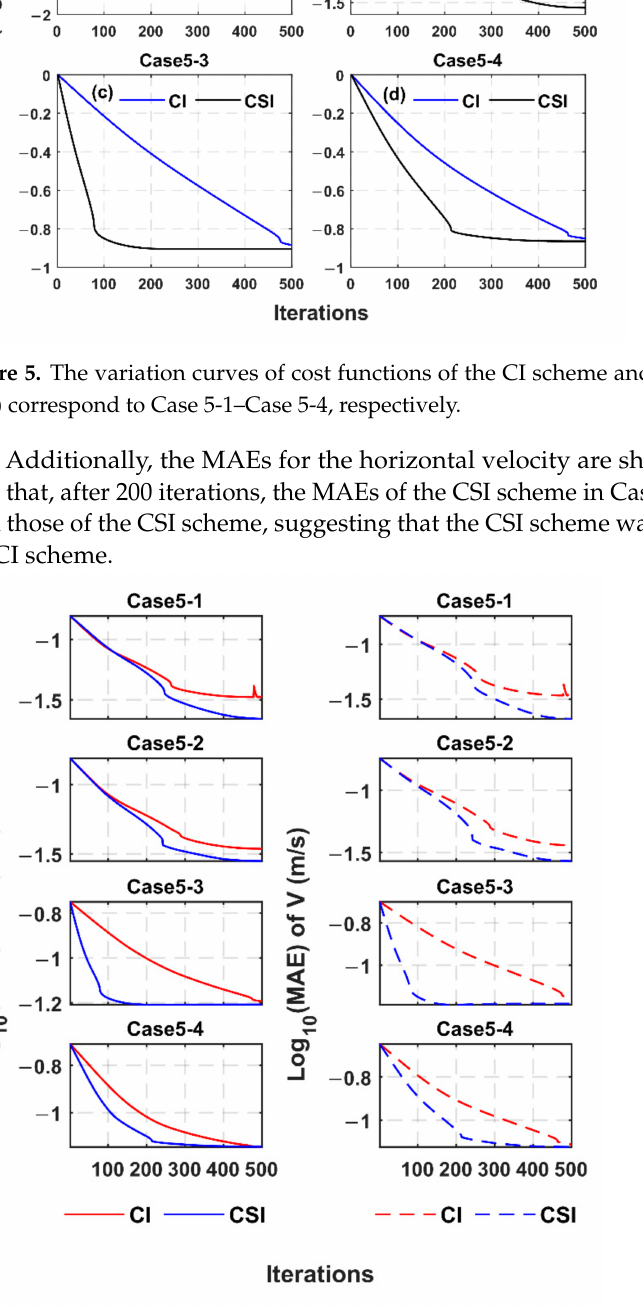
Figure 6. The MAEs of the horizontal velocity component (u, v) with the assimilation steps after adding 3%, 5%, 10%, and 15% errors (the figure shows the result after taking logarithm log 10